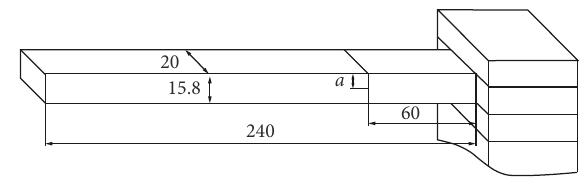
Figure 10: Dimensions of a cantilever beam with a crack.